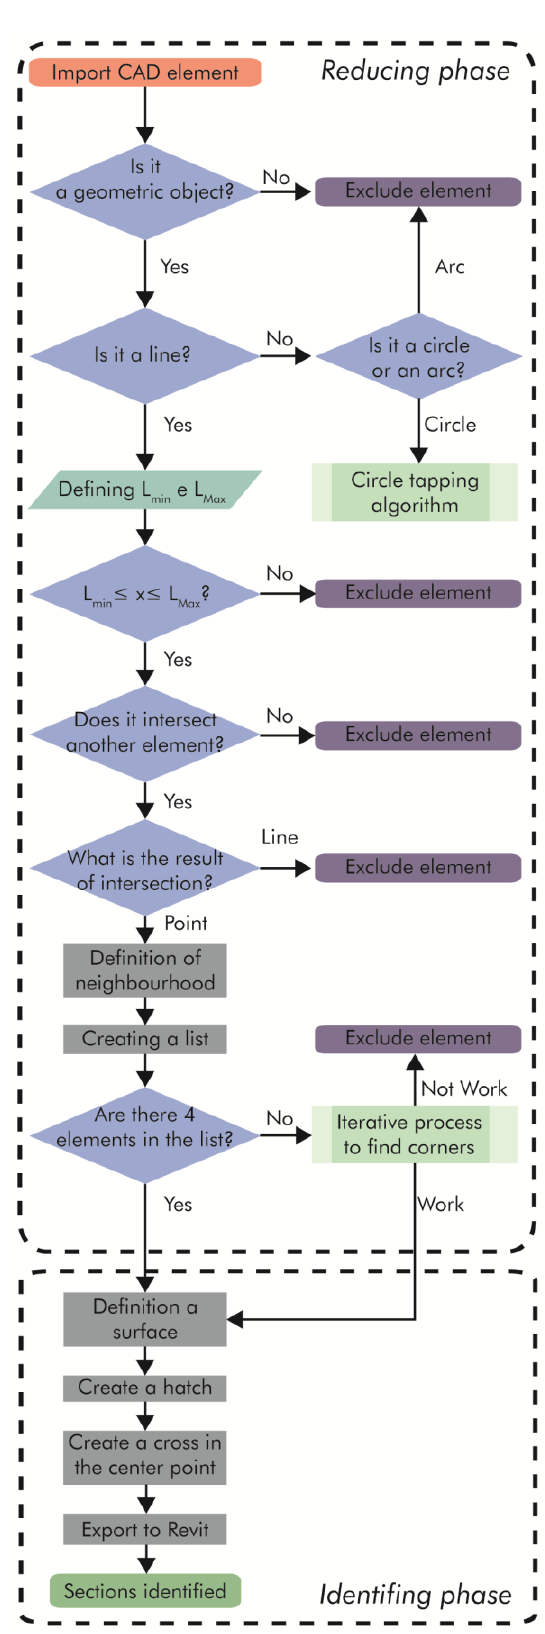
Figure 3. Functioning of the analytical algorithm. On the top, Figure 2. Flowchart of the analytical algorithm for quadrangular process start. On the centre, processing phase. On the bottom, final sections phase and